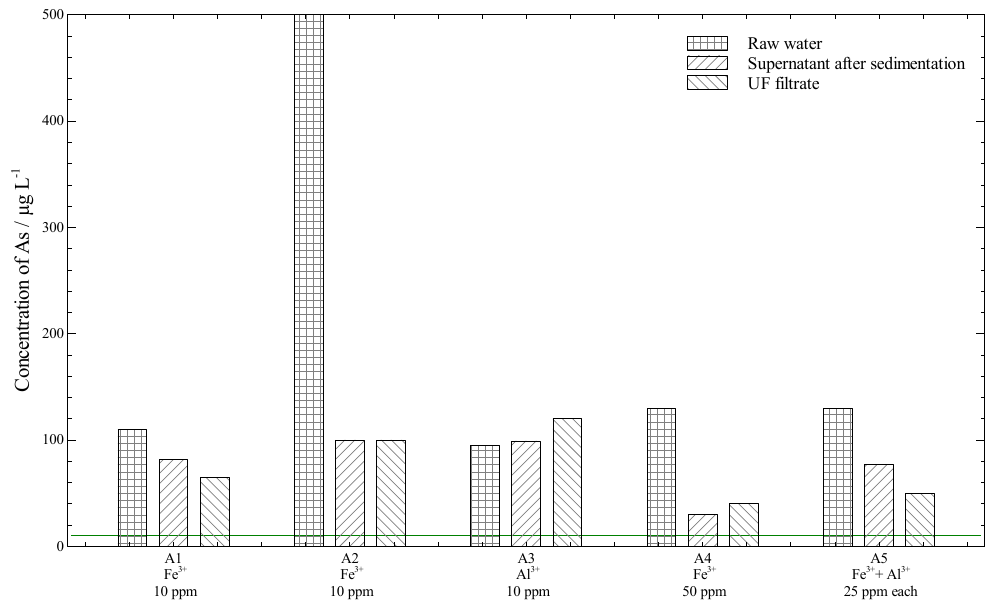
Figure 2. Arsenic removal efficiency after coagulation, sedimentation and UF filtration with different dosing rates of iron and aluminium coagulants for raw water spiked with 100 or 500µgL − 1 of As(III). The green line shows the WHO limit of 10µgL − 1